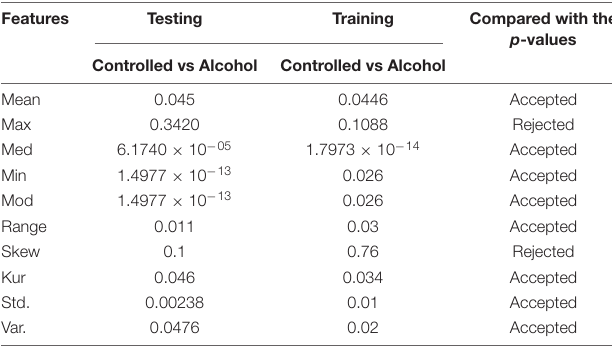
TABLE 6 | Feature set outcome of Experiment No. 6.